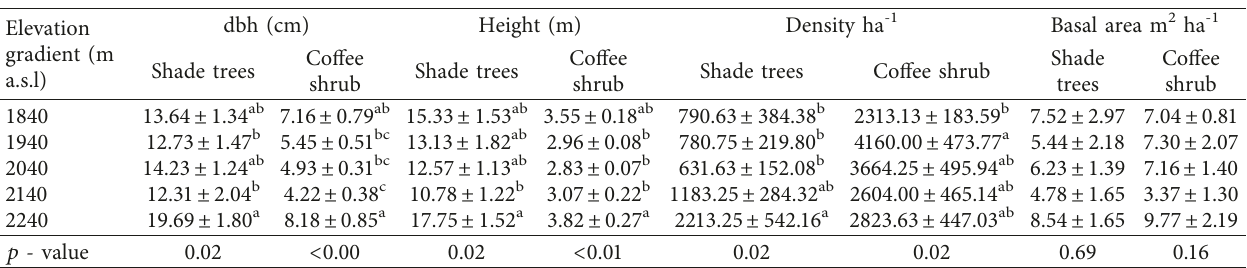
Table 3: Mean value of woody species dbh, height, density, and basal area along an elevation gradient of coffee-based agroforestry system.